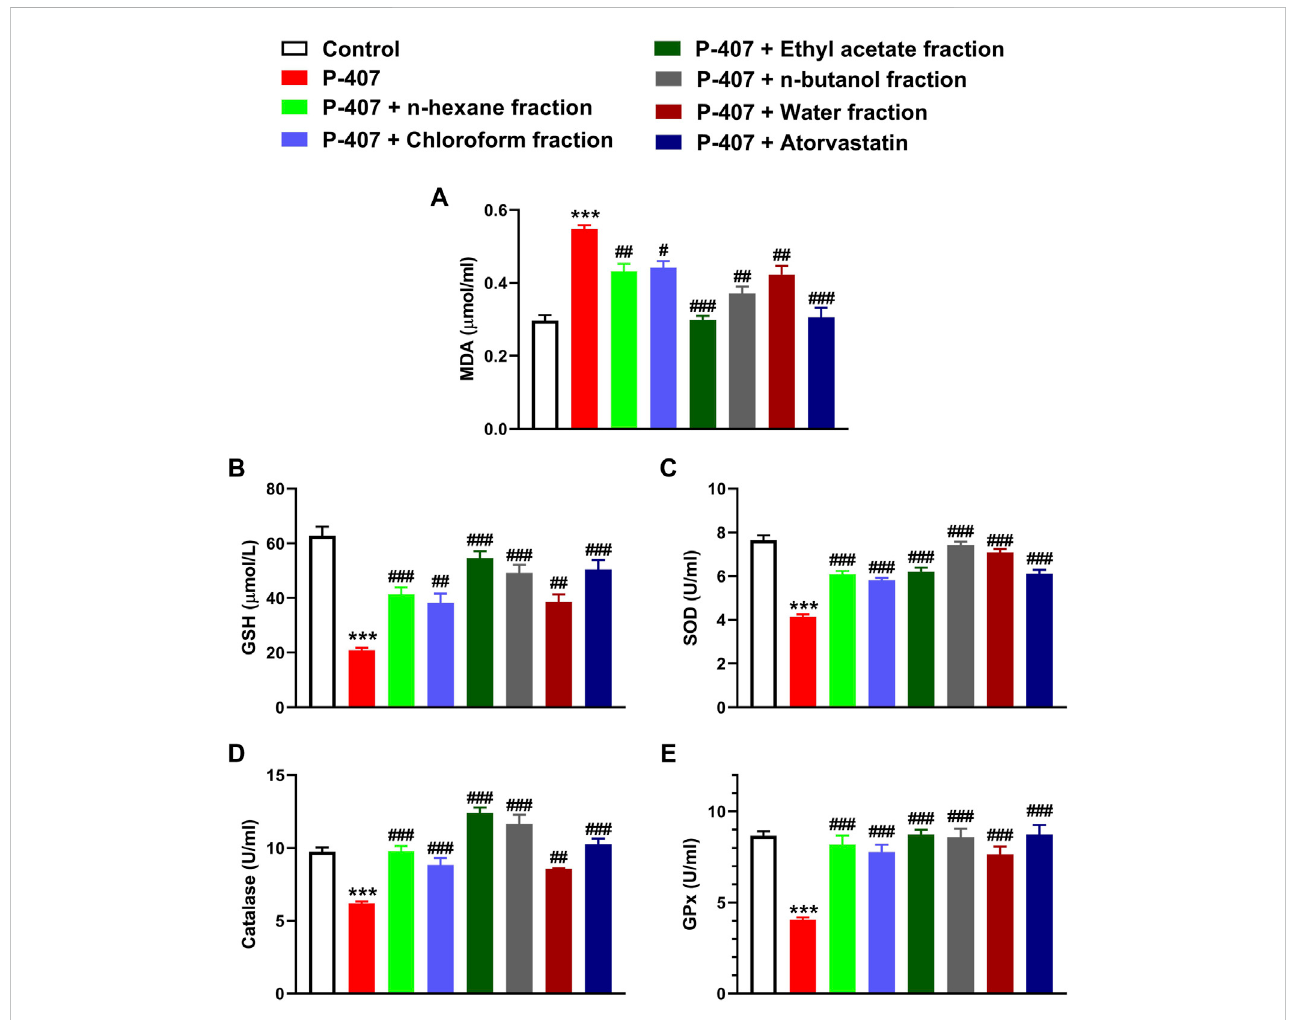
FIGURE 9 EffectofdifferentfractionsofMEACL (A) MDA, (B) GSH (C) SOD, (D) CAT,and (E) GPxinP-407-inducedacutehyperlipidemicrats.Valuesarerepresented as mean ± SEM ( n = 6). *** p < 0.001 versus Control, and # p < 0.05, ## p < 0.01, and ### p < 0.001 versus